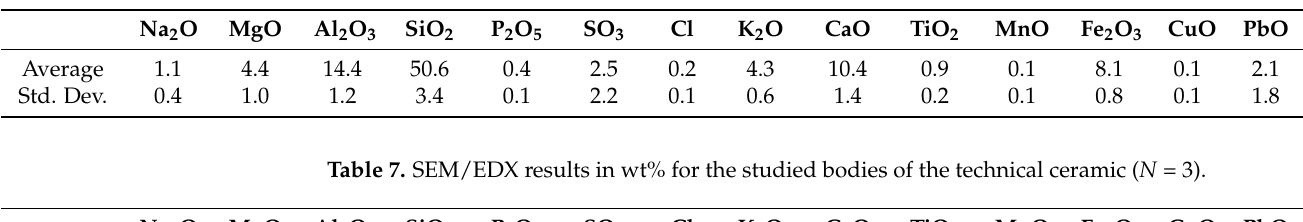
Table 6. SEM/EDX results in wt% for the studied clay bodies of vessels ( N = 4).